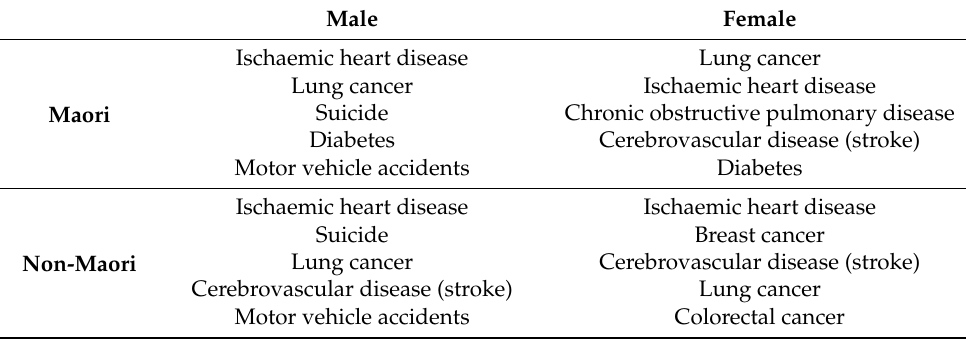
Table 2. Leading causes of Death for Maori and Non-Maori [18]. Male Female Ischaemic heart disease Lung cancer Lung cancer Ischaemic heart disease Suicide Chronic obstructive pulmonary disease Maori Diabetes Cerebrovascular disease (stroke)